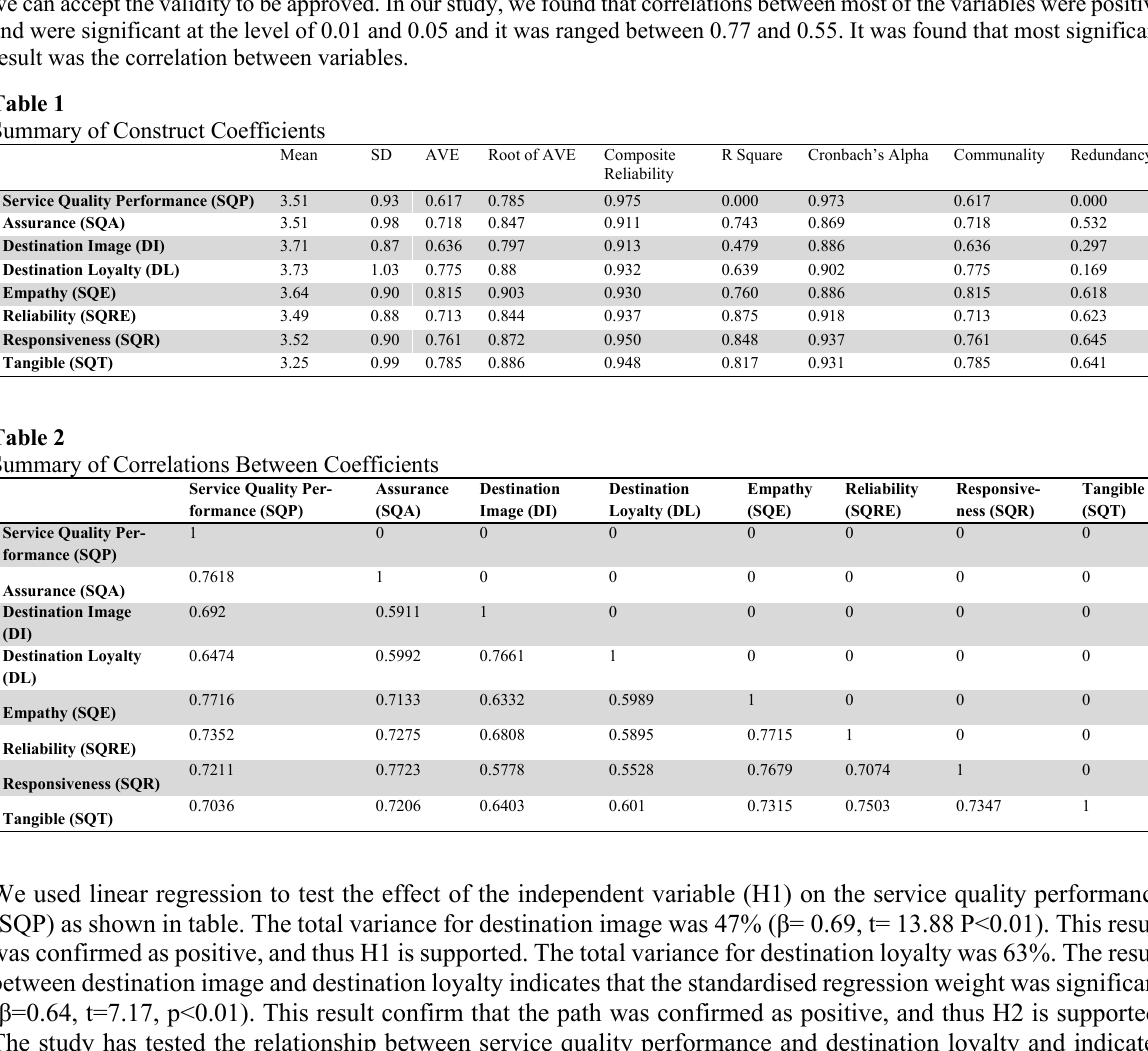
Summary of Construct Coefficients